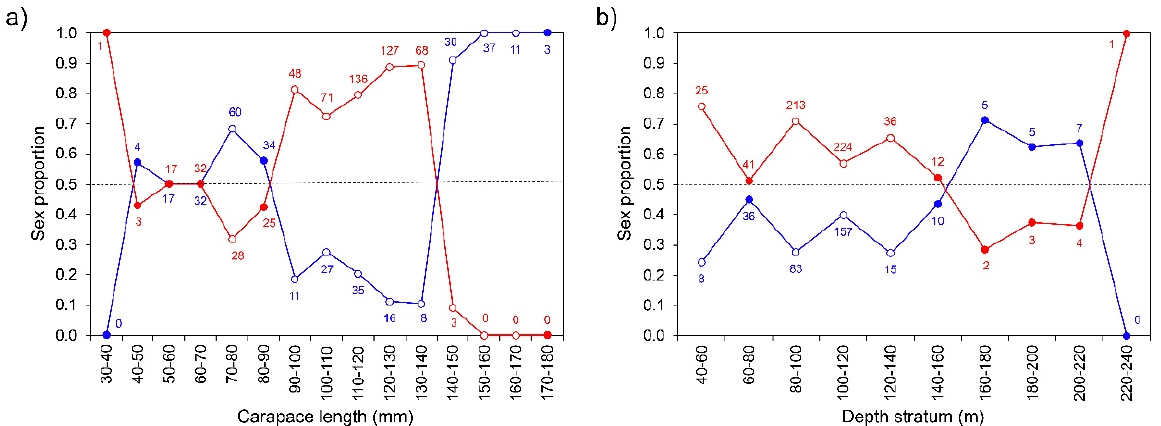
Figure 3. Proportion of males (in blue) and females (in red) of Palinurus elephas by size class ( a ); and depth stratum ( b ) in the Azorean region during the period 2000–01. Numbers inside the graph represent the number of individuals ( n ). Open circles denote statistically significant differences ( p -value < 0.05) between sexes.